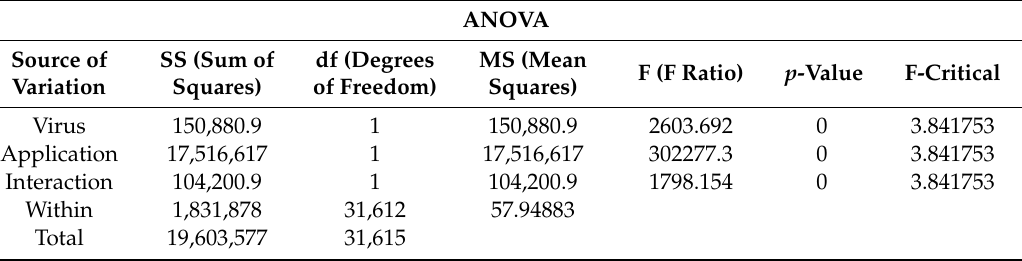
Table 5. Two-way